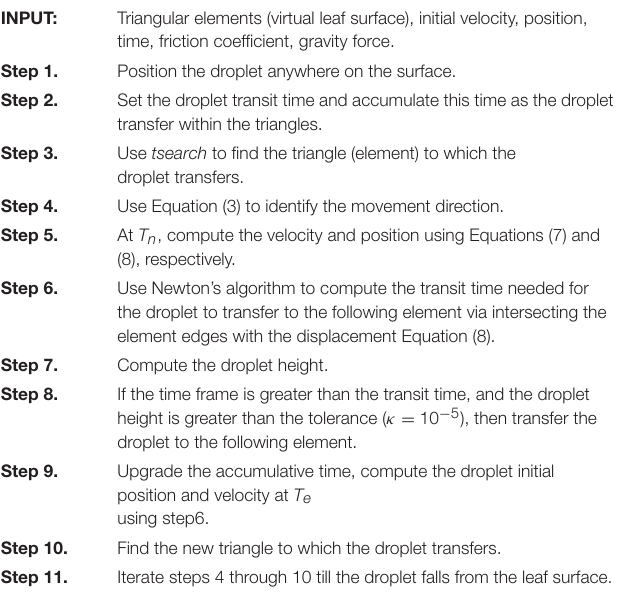
Algorithm 4.1. Water droplet flow